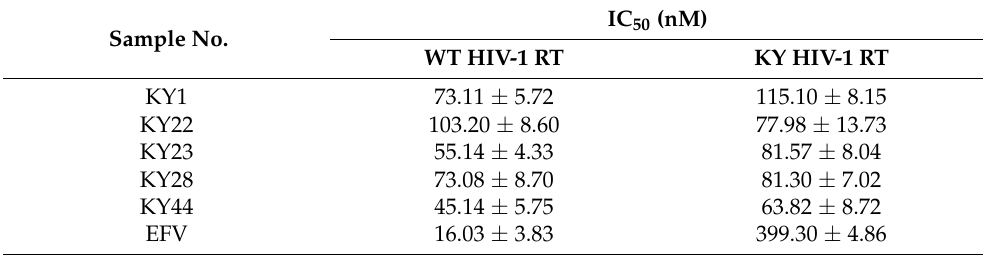
Table 1. IC50 values of synthesized KY DNA aptamers on HIV-1 RTs DNA polymerase function. Sample